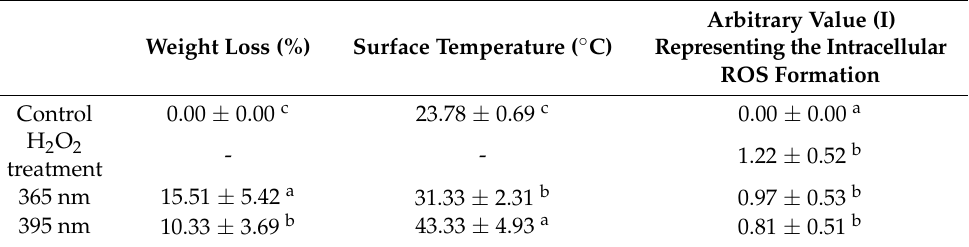
Table 2. Effect of 365 and 395 nm LED treatment on the weight and surface temperature of low-a w S. Typhimurium ATCC13311. Intracellular ROS generation using carboxy-H2DCFDA dye in low-a w S. Typhimurium due to the 365 and 395 nm LED treatments is also shown. The 365 and 395 nm LED treatments were performed at 80% power level and at 4 cm from the LED head with the ~217 J/cm 2 dose corresponding to treatment times of 60 and 12 min, respectively. The low-a w S. Typhimurium cells treated with 200 mM H 2 O 2 for 30 min served as the positive control. Here the arbitrary value I = (I t − I o )/I o , where I t and I o are the mean fluorescence values of the treated and untreated low-a w S. Typhimurium, represents the intracellular ROS generation.